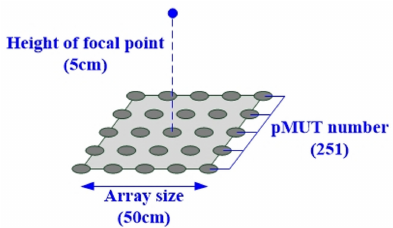
Figure 11. Schematic of the pMUT arrays model.